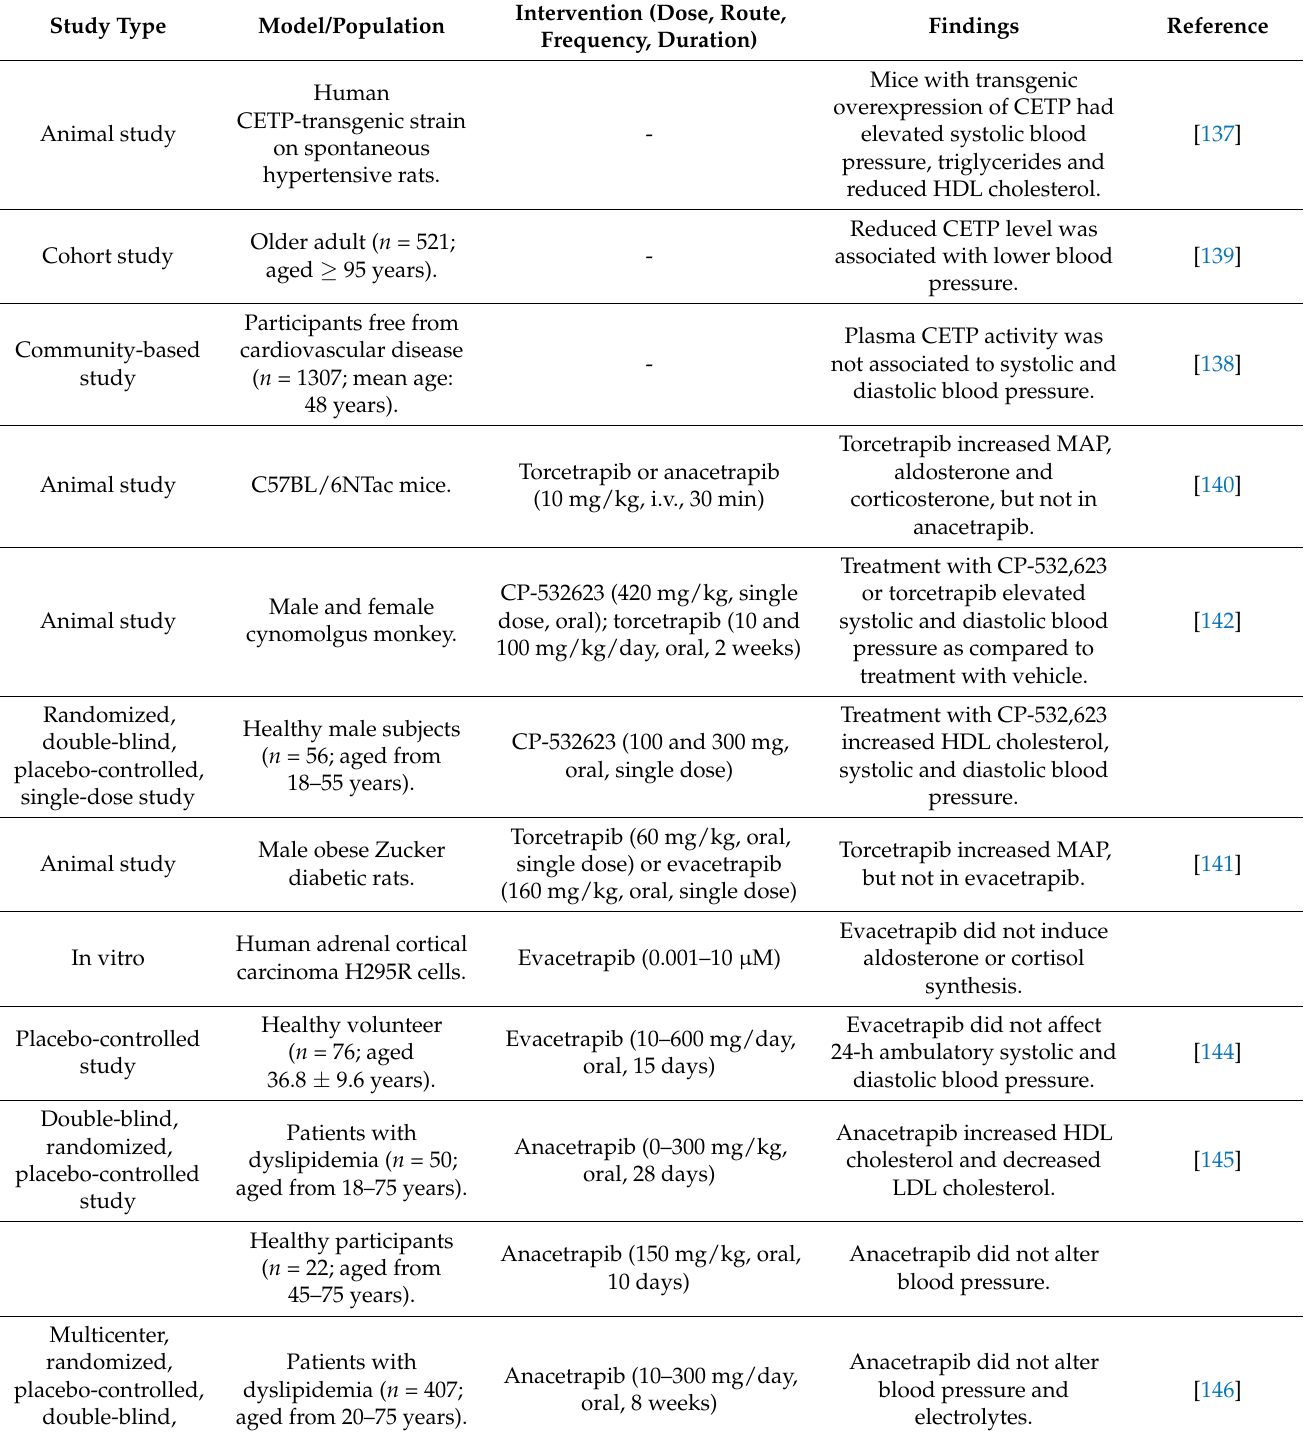
Table 9. The relationship between CETP and blood